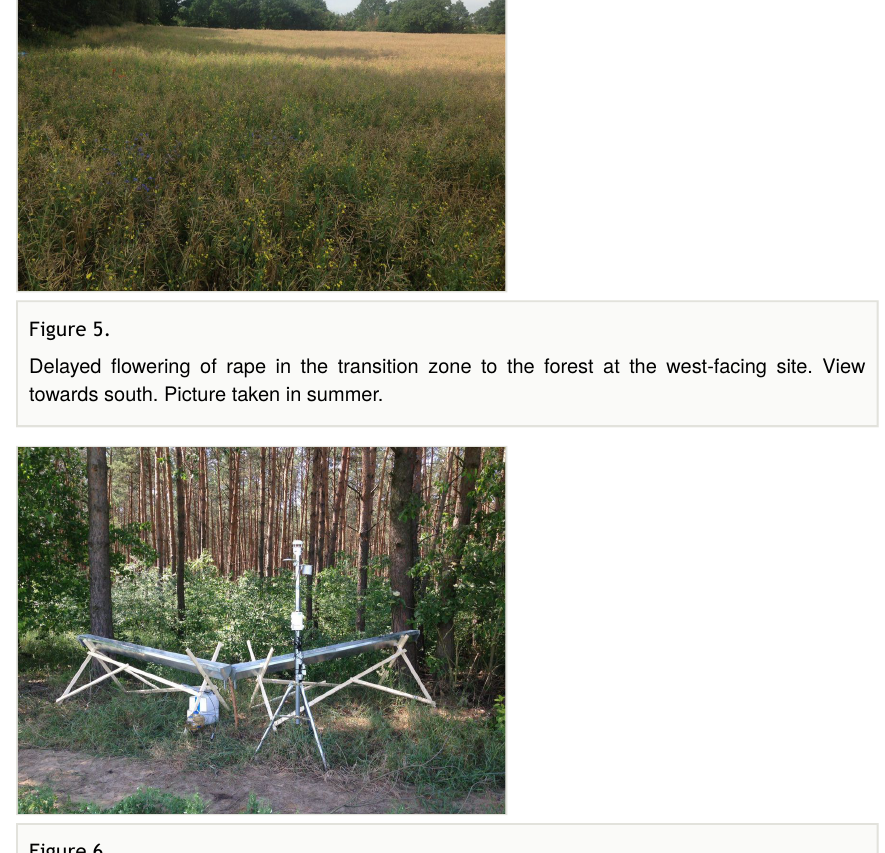
Setting of weather stations in the forest (zero line, -35 m and -70 m) with rain